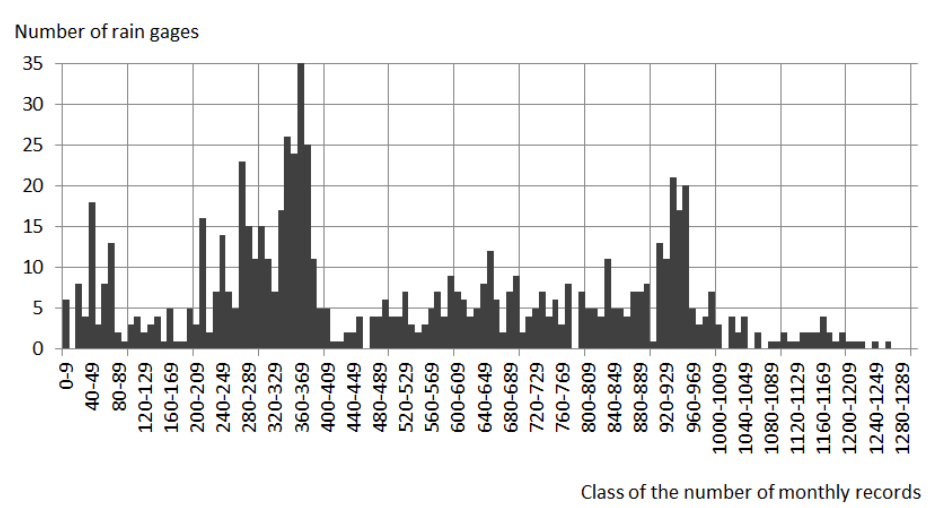
Figure 2. SNIRH database [44]. Number of rain gauges, out of 764 rain gauges, per class of available number of monthly records, from October 1910 to September 2019 (total number of months of 119 × 12 =